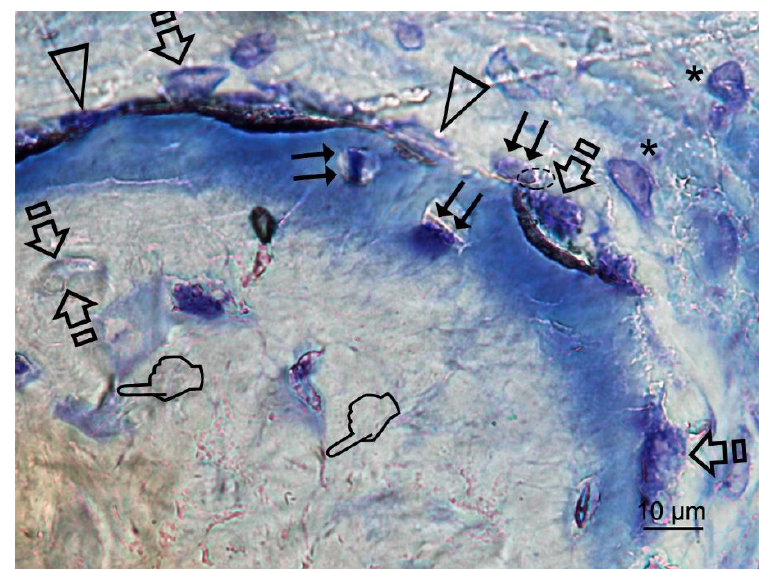
Figure 5. Bone histology images obtained after using Dox-HOOC-Si-membrane, by dye with toluidine blue to visualize mineralized bone, at six weeks of healing time. Single arrows point to the presence of osteoclasts. As opposed to the contact surface of the bone through the ruffled border forming a sealing zone (podosome), the functional secretory domain can be adverted at the peak of the single arrows. Osteoclasts and osteoblasts connect with each other through direct cell-cell contact and extracellular matrix interaction (dotted circle). Double arrows indicate osteoblasts, and pointers mean canaliculi and faced arrows, osteocyte. Asterisks are located close by some macrophages. Lining cells, in close contact with osteoclasts, are signaled by arrow head. Polymers 2020 , 12 , x FOR PEER REVIEW